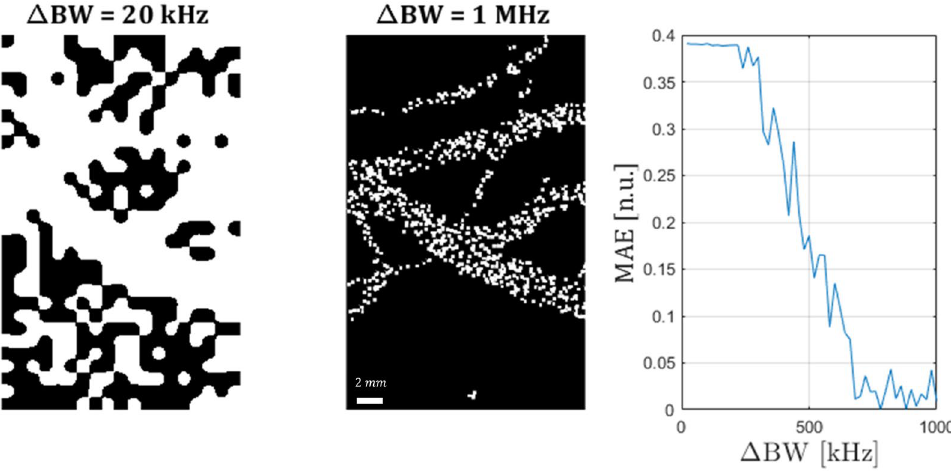
Figure 6. Bandwidth sparsity requirement — simulation results. In the left image, the worst sparsity (20 kHz difference of bandwidth) is presented. In the middle, the image with sparsity of 1 MHz is presented. The graph on the right demonstrates the mean average pixel error (MAE) as function of